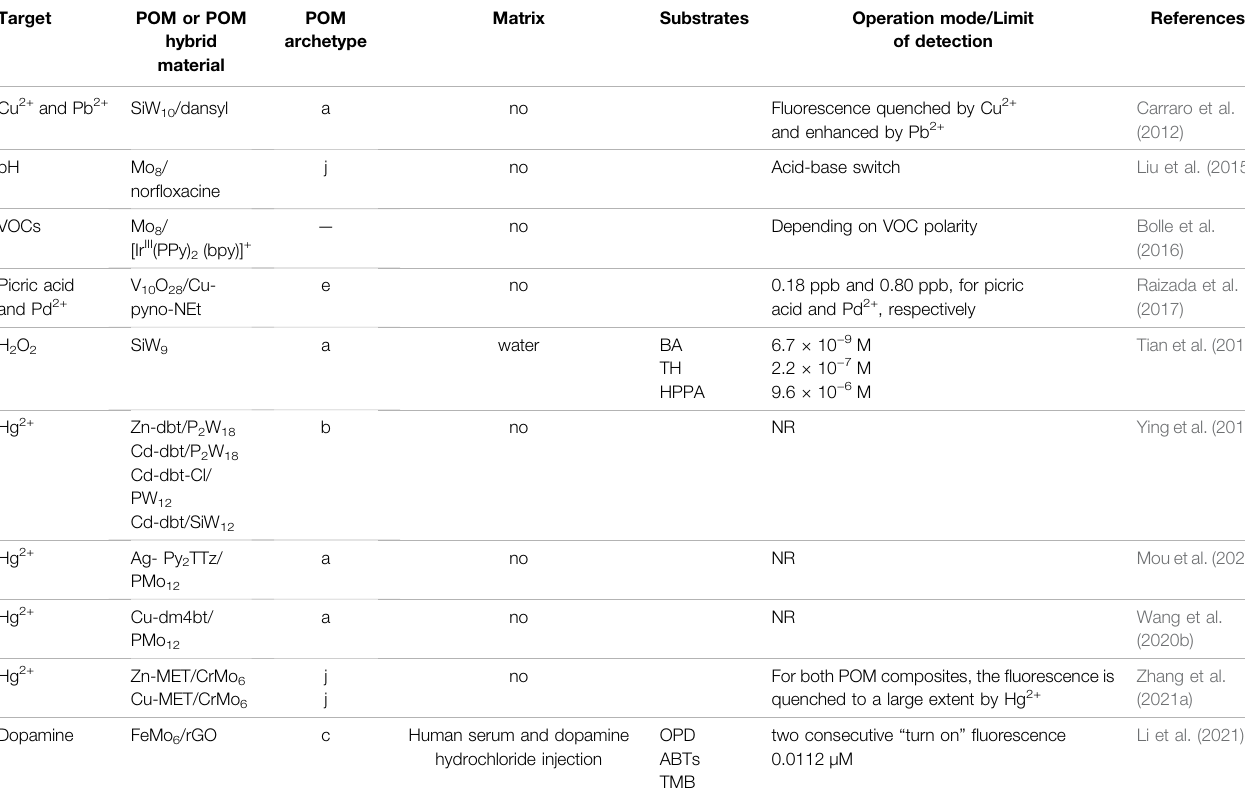
TABLE 9 | POM-based fl uorescence optical sensors.